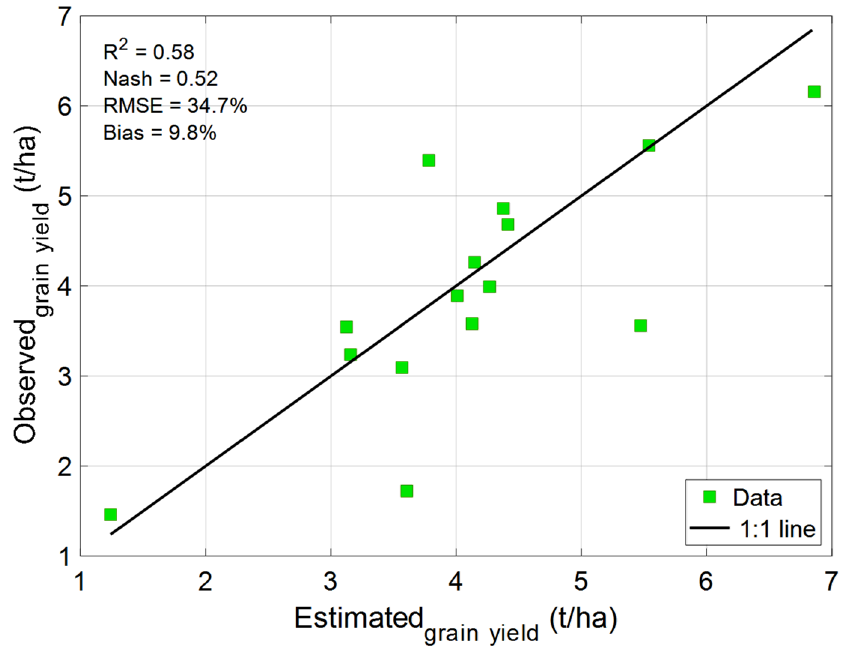
Figure 6. Assessment of the model performance using the cross-validation.